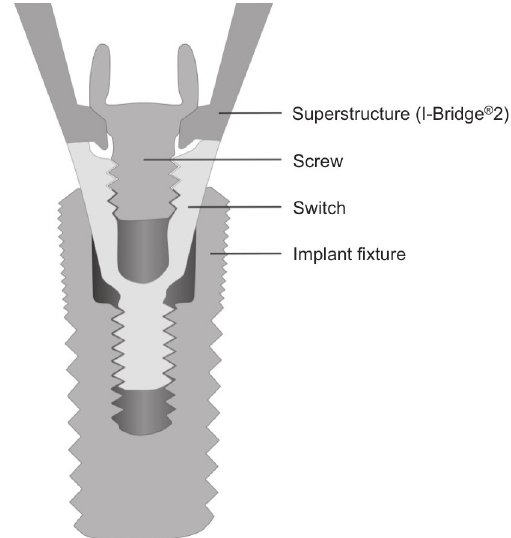
Figure 1- Schematic cross-section of the I-Bridge ® 2